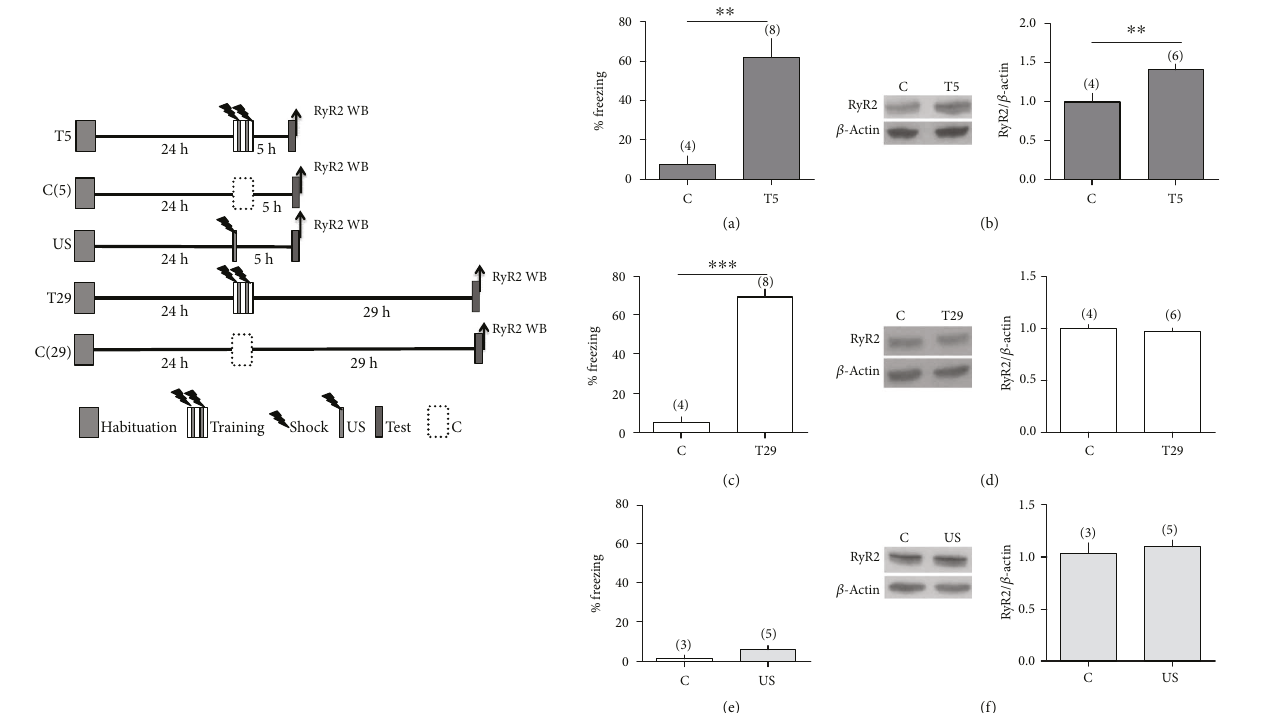
Figure 1: Context conditioned fear memory consolidation causes transient increases in RyR2 protein content. (a, c) Memory retention (% freezing) was measured 5h (T5) or (c) 29h (T29) after training or after context exposure without the aversive stimulus as control. (b, d) RyR2 protein content was analyzed 5 and 29 h after training, respectively. Representative blots and bar graphs illustrate RyR2 hippocampal content in each group of rats. (e, f) Memory retention and RyR2 hippocampal protein contents were measured (c) 5h after exposure to the context or after unpaired stimulation (US). Values represent mean ± SE; the number of independent determinations is indicated in each graph. Statistical analysis was performed with unpaired Student ’ s t -test; ∗∗ p < 0 01 , ∗∗∗ p < 0 001